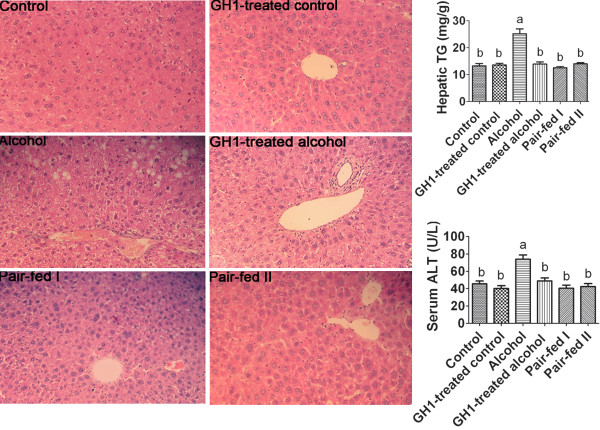
Liver histology. Accumulation of lipid droplets is evident in the liver of alcohol-fed mice, while relatively few lipid droplets were found in the hepatocytes of other groups (hematoxylin/eosin staining; original magnification, × 40). Serum ALT levels show similar trends to hepatic TG content in all groups. GH1 therapy reversed the alcohol-diet-induced increases in hepatic TG and serum ALT. ALT: alanine transaminase; TG: triglyceride. n = 6 mice per group. Means without a common letter differ at P < 0.05 vs. the control group.